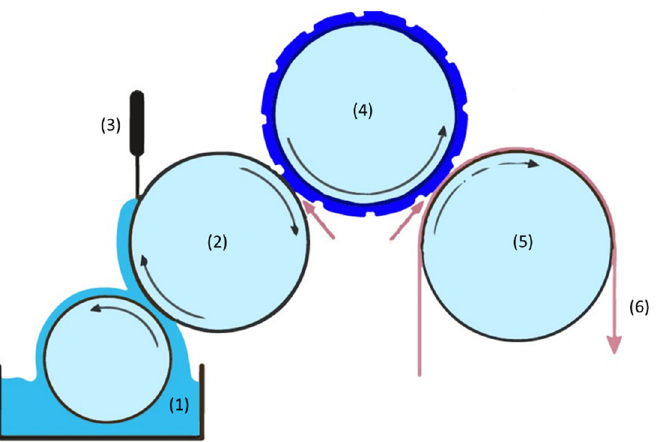
Figure 1. Significant parts of the flexography process: inking unit (1); anilox roller (2); doctor blade (3); plate cylinder (4); impression cylinder (5); printing substrate (6).